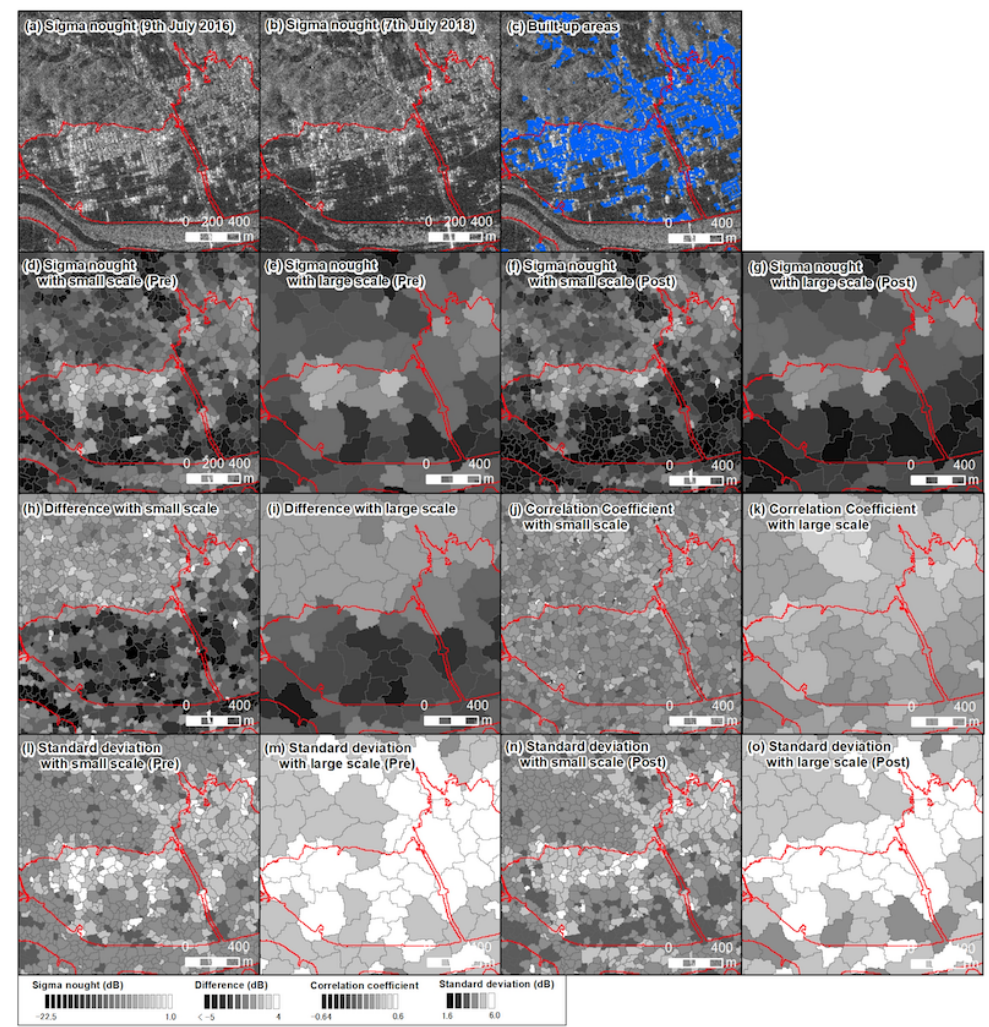
Figure 13. Examples of segmentation: ( a ) sigma nought image on 9 July 2016; ( b ) sigma nought image on 7 July 2018; ( c ) distribution of built-up areas; ( d – o ) segmentations with several types of variables: ( d ) pre-event sigma nought with small scale, ( e ) pre-event sigma nought with large scale, ( f ) post- event sigma nought with small scale, ( g ) post-event sigma nought with large scale, ( h ) difference image with small scale, ( i ) difference image with large scale, ( j ) correlation coefficient image with small scale, ( k ) correlation coefficient image with large scale, ( l ) pre-event standard deviation with small scale, ( m ) pre-event standard deviation with large scale, ( n ) post-event standard deviation with small scale, ( o ) post-event standard deviation with large